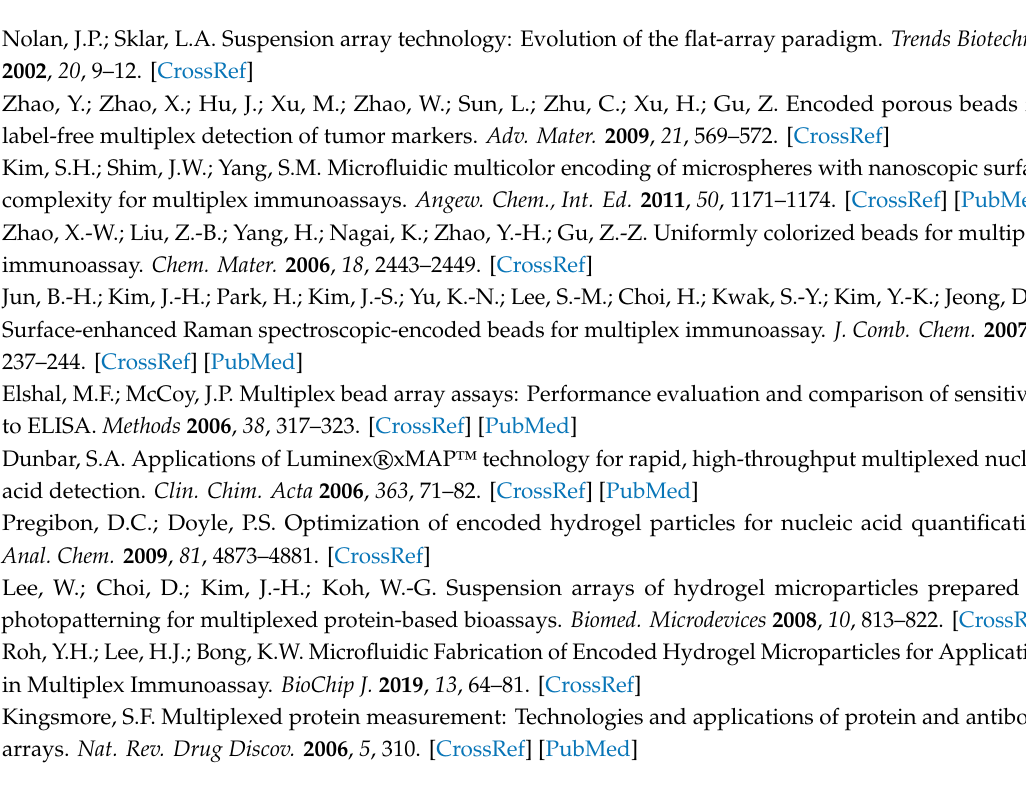
Figure S1: Kinetics of the aza-Michael addition reaction, Figure S2: Fluorescence intensity of particles versus streptavidin concentration, Figure S3: Stability of streptavidin conjugated in encoded hydrogel microparticles, Figure S4: DNA probe density of particles as a function of streptavidin concentration, Figure S5: Specificity test using two DNA targets, Figure S6: Standard calibration curves of two cancer-related miRNAs, and Table S1: Sequences of DNA and miRNA targets, probes, and the universal